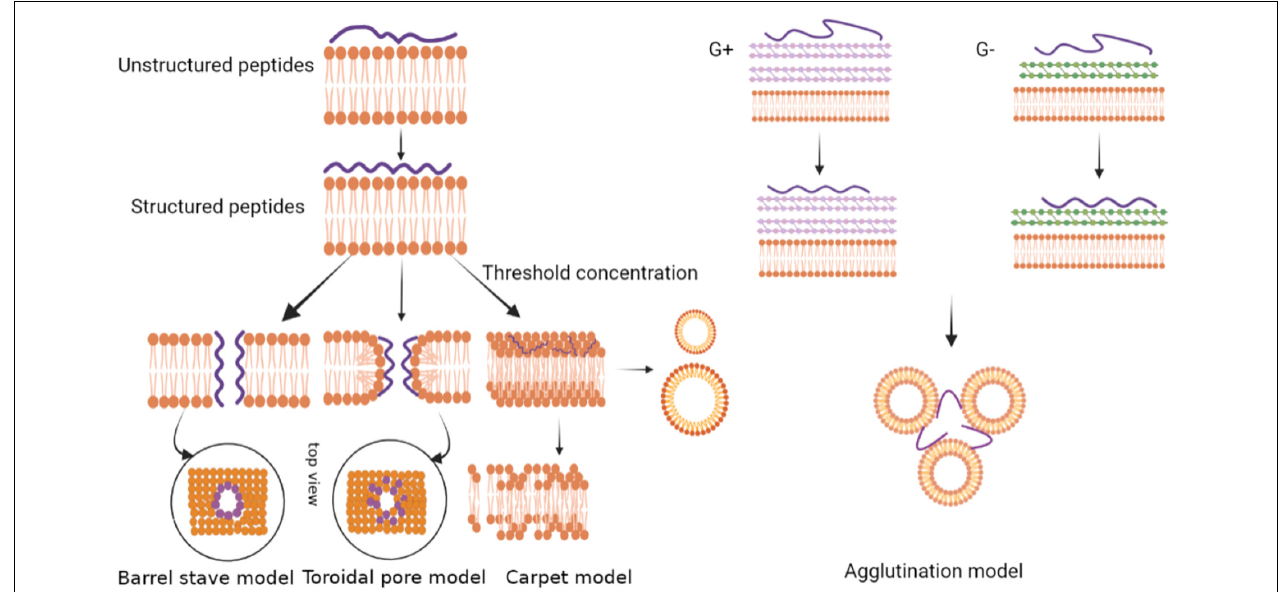
FIGURE 3 | Models depicting the mode of action by membrane-active antimicrobial peptides.